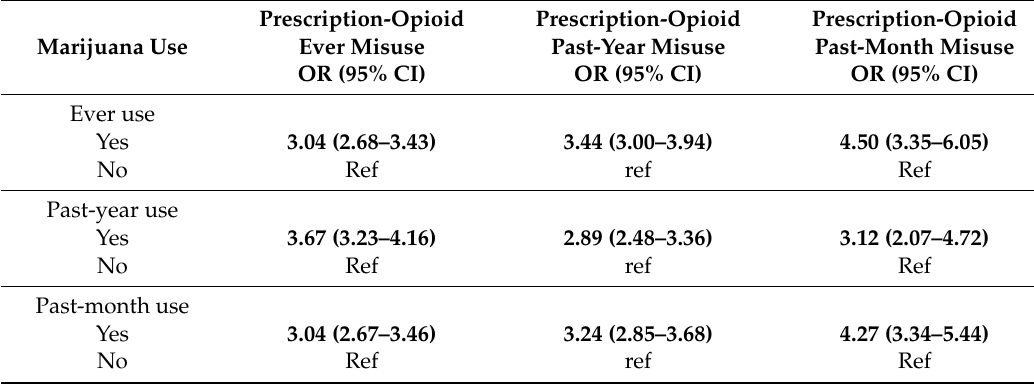
Table 2. Association between prescription-opioid misuse and marijuana past-month use